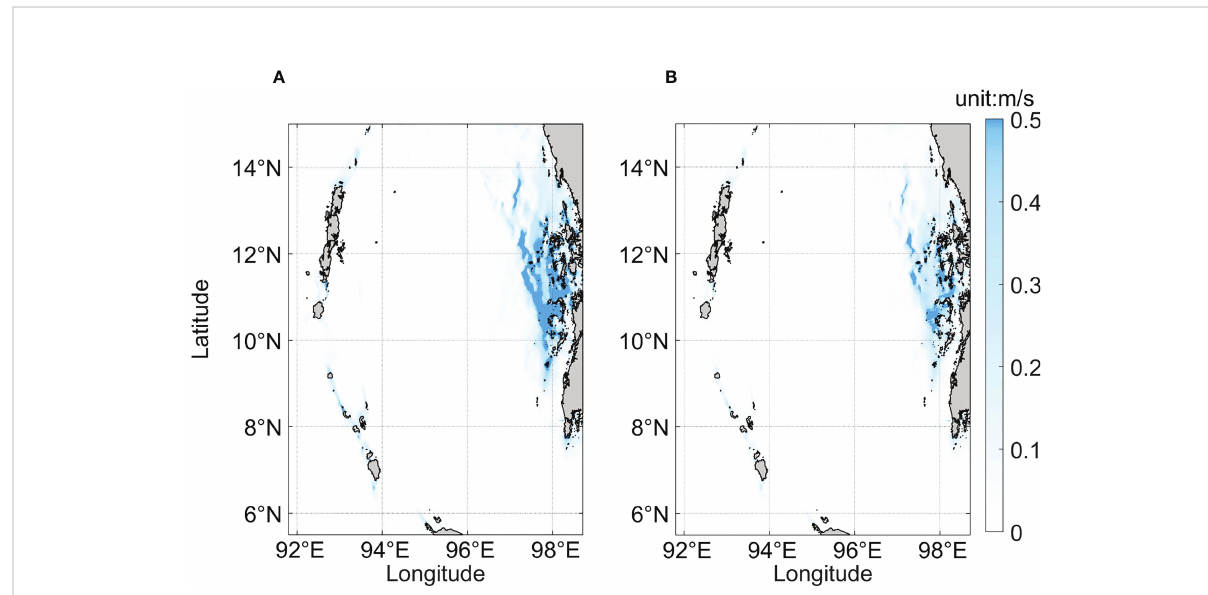
FIGURE 4 EARMS of zonal velocity of (A) M2 tidal constituent and (B) S2 tidal